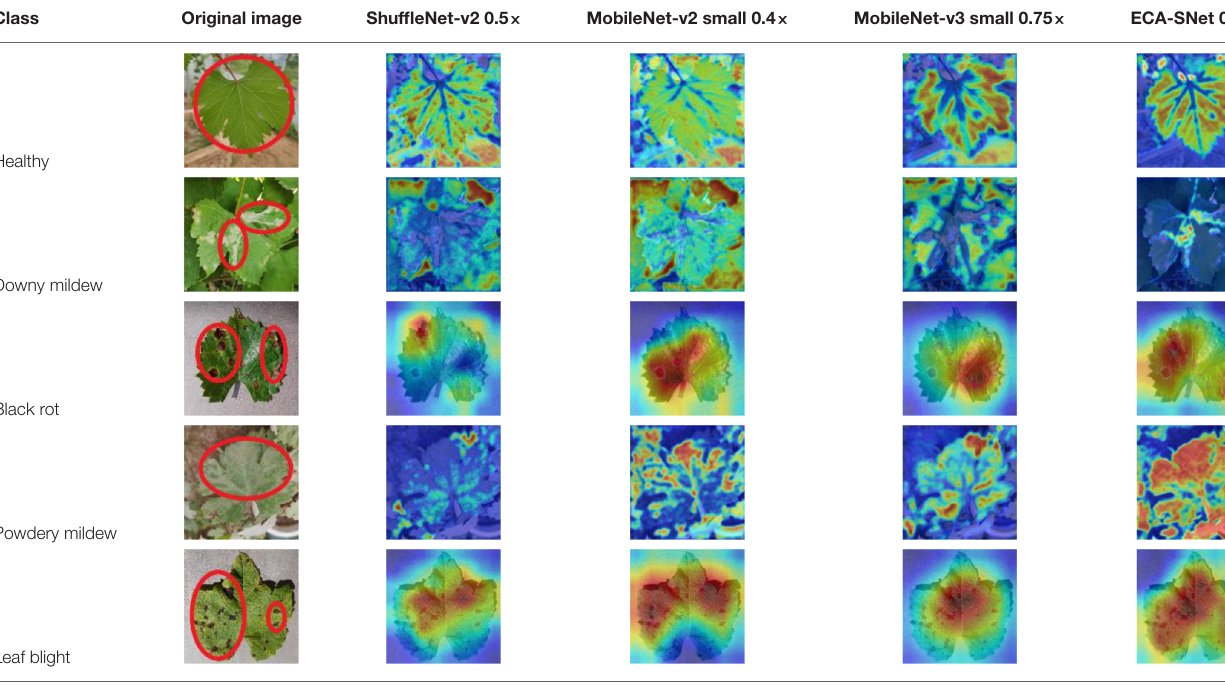
TABLE 5 | Visualization of attention heat map of grape leaf